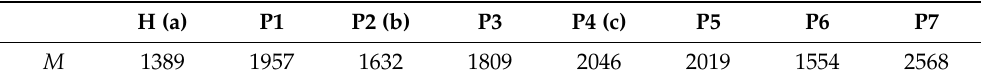
Table 1. Number of movements M for a healthy participant (H) and stroke patients (P) computed with path-based segmentation